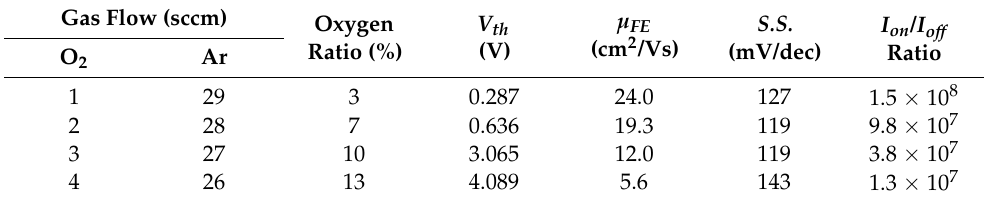
Figure 1. ( a ) The schematic of a BMG a-IWO TFTs. ( b ) The illustrated DOS distribution in a-IGZO. Table 1. Extracted device parameters with different oxygen ratios.